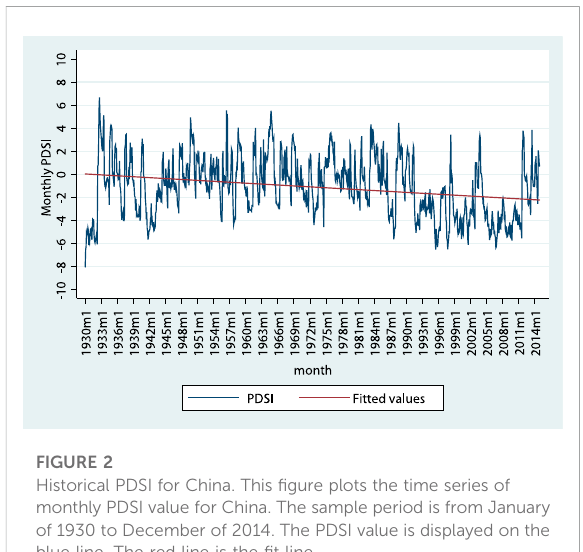
FIGURE 2 Historical PDSI for China. This fi gure plots the time series of monthly PDSI value for China. The sample period is from January of 1930 to December of 2014. The PDSI value is displayed on the blue line. The red line is the fi t